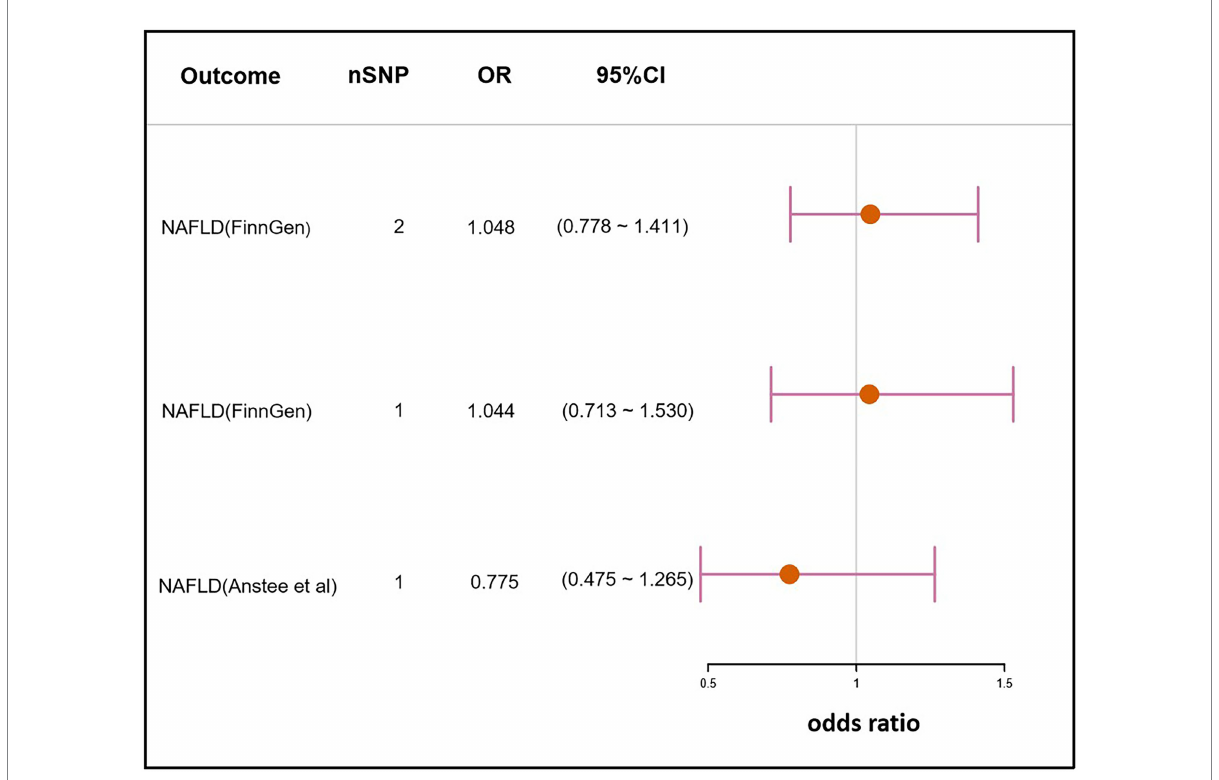
FIGURE 2 Mendelian randomization result of the effect of H. pylori infection on NAFLD. nSNP, the number of SNPs used in the analysis, and the SNP rs10004195 was used if nSNP = 1. The SNPs rs10004195 and rs368433 were used if nSNP = 2. OR, the odds ratio. 95% CI, 95% confidence interval.